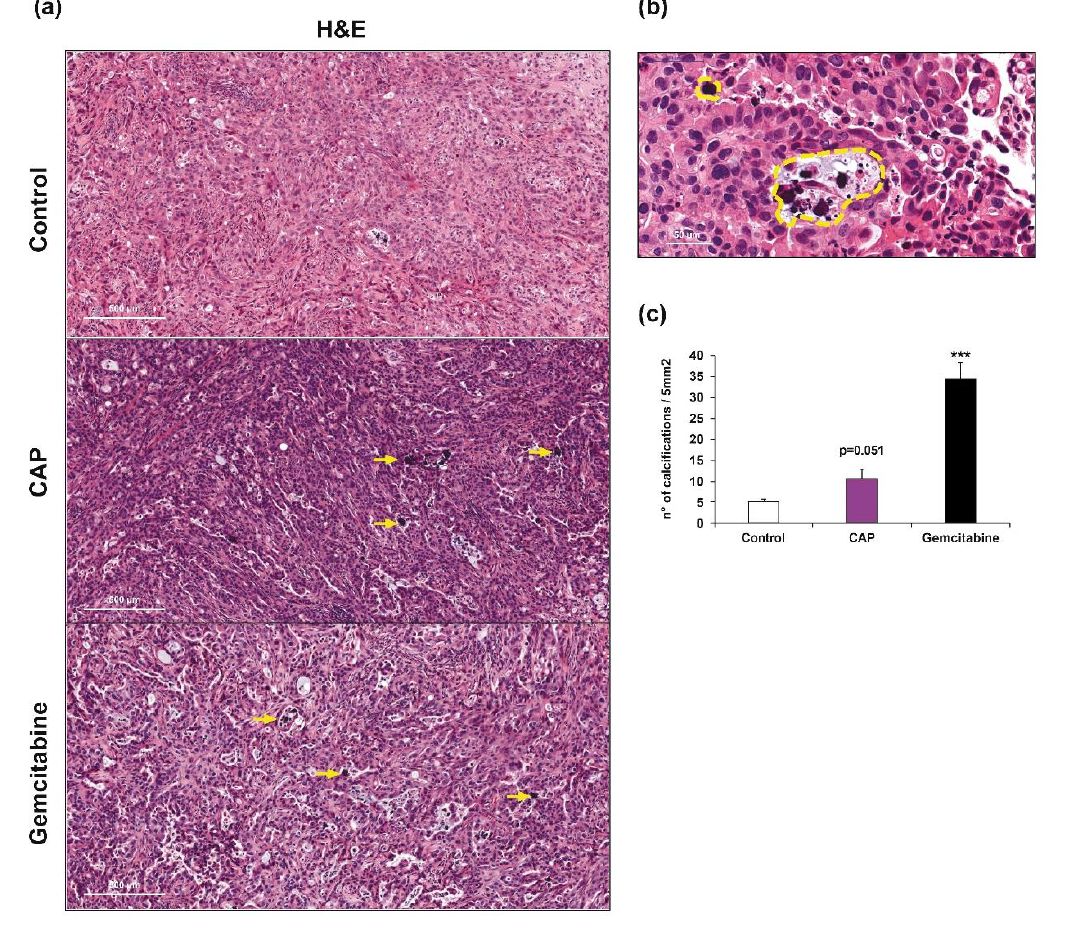
Figure 2. ( a ) Representative HE staining of control (upper panel), CAP (middle panel) and gemcitabine (bottom panel) treated xenograft tumors. Magnification × 125. Scale: 500 μm. ( b ) Magnification (×1000) of calcifications corresponding to apoptotic bodies (outlined in yellow). Scale: 50 μm. ( c ) Quantification of apoptotic structures. ***, p < 0.001; compared with control tumors.